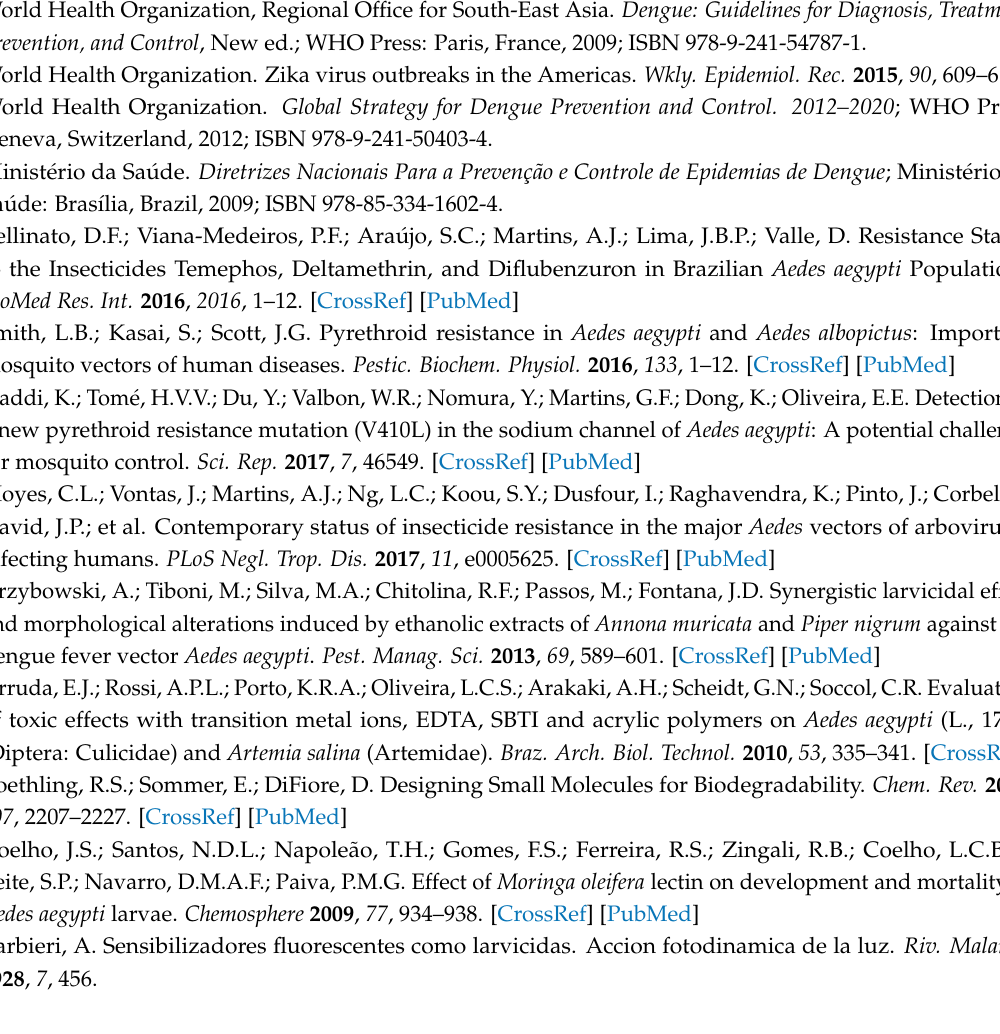
Figure S1: Larval mortality rate as a function of time induced by Temephos at different concentrations: (#) 0.012, (.) 0.12, (9) 0.5, ( ∆ ) 1.0 µ g mL − 1 . Error bars represent